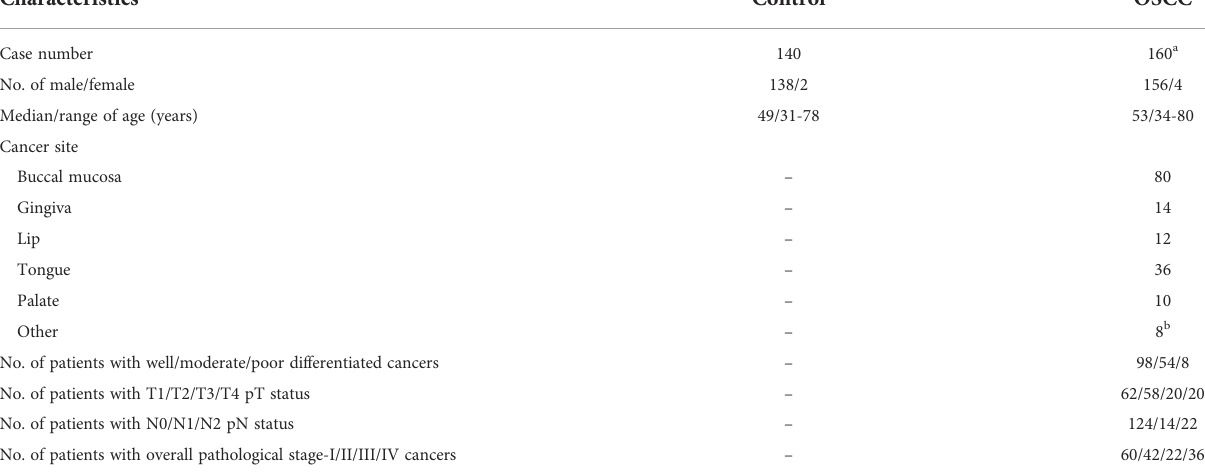
TABLE 1 Characteristics of origins of saliva samples used for auto-Ab detection.